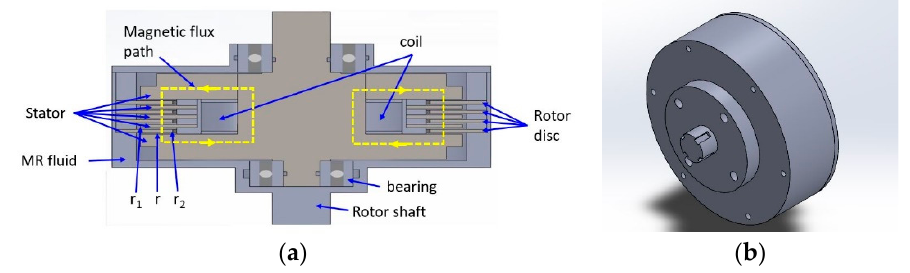
Figure 4. Single-pole multilayer MR brake ( a ) cross-sectional view ( b ) isometric view [27]. The torque of the MR brake ( T MR ) is the sum of the yield stress torque ( T yd ) and the viscosity torque ( T vis ) and is represented by the below Equation (8).